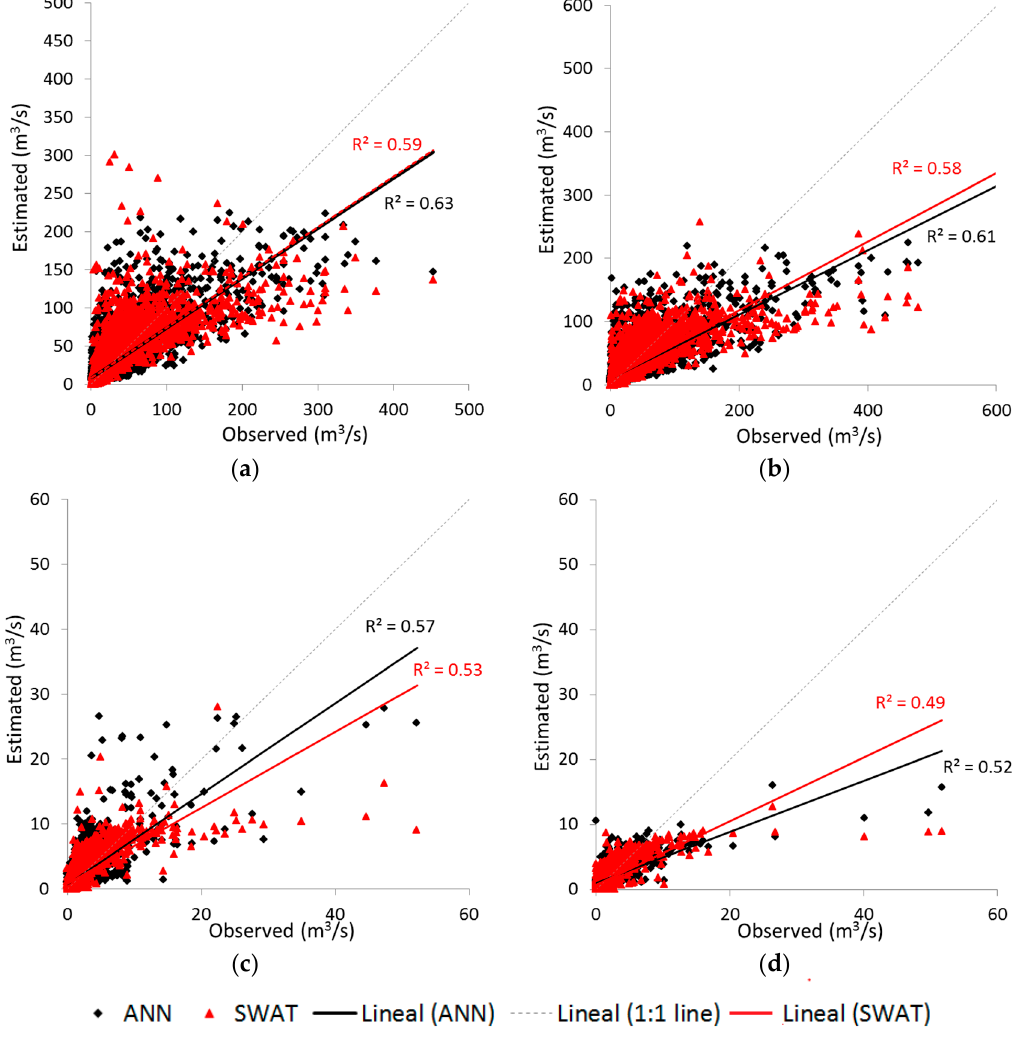
Figure 4. Scatterplots for daily streamflow obtained with SWAT and ANN in ( a ) calibration/training period of LRB; ( b ) validation period of LRB; ( c ) calibration/training period of HSRB; ( d ) validation period of HSRB.